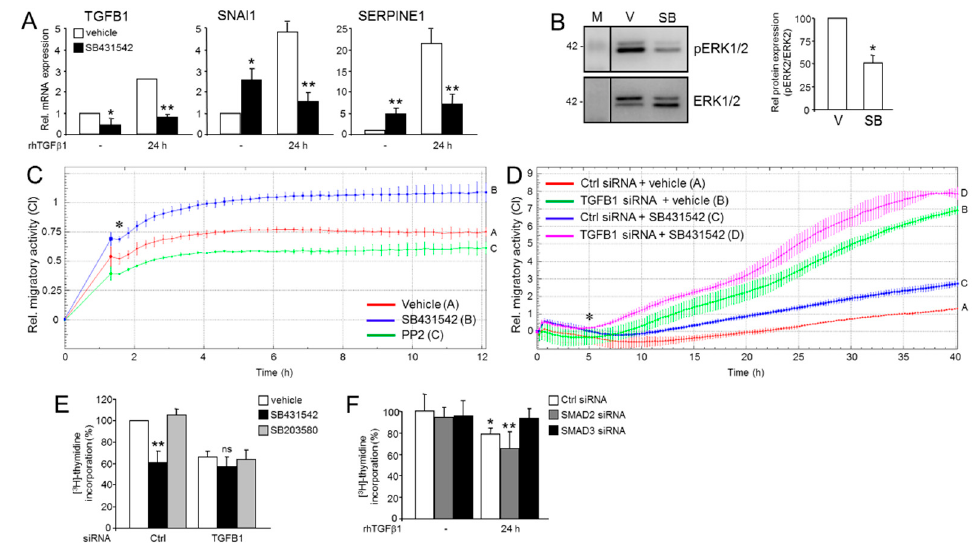
Figure 6. Effects of SB431542 on endogenous TGF β 1 expression, ERK activation, and cell migration. ( A ) Panc1 cells were treated, or not, for 24 h in the absence or presence of SB431542 (1 µM), or vehicle (0.1% DMSO) followed by qPCR analysis of TGFB1 , SNAI1 or SERPINE1 and GAPDH and TBP as internal control. Data represent the normalized mean ± SD of